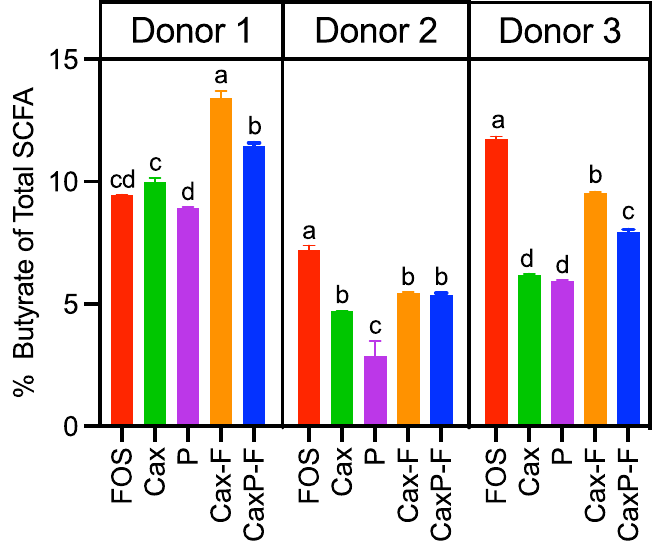
Figure 4. Butyrate percentage ratio generated at 24 h in vitro fecal fermentation in three donors. Error bars represent the standard error of the mean of three replicates. Different letters indicate significant differences in butyrate among treatments at the same time point (Tukey’s multiple comparison test, α = 0.05).